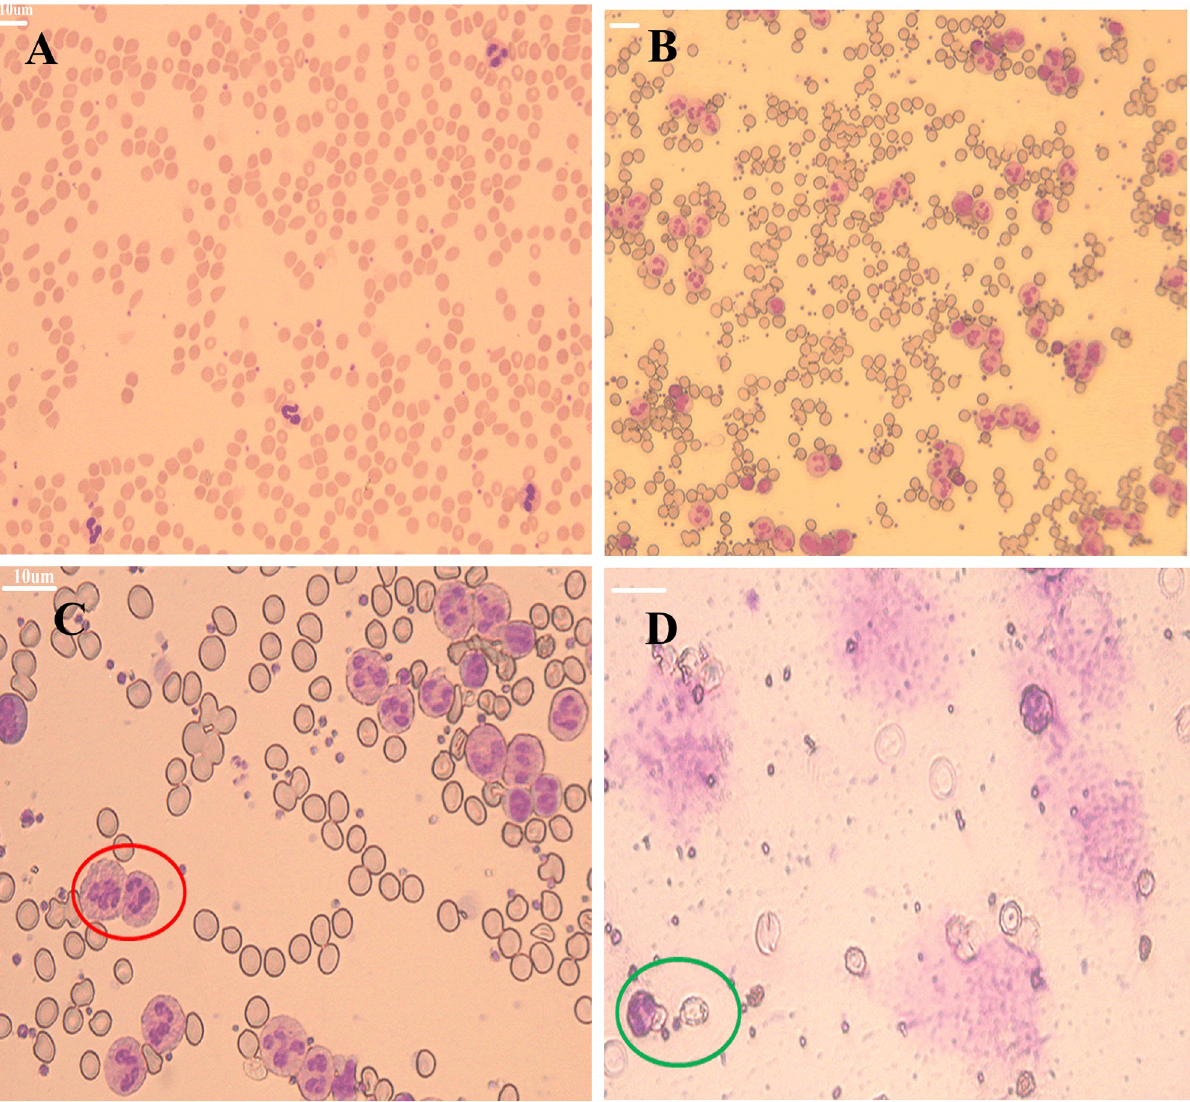
Fig 6. Morphology analysis of leukocytes respective after cell lysis and the LSA-3 pushing style method. (A) Wright-Giemsa staining of whole blood samples obtained using a 20x microscope objective. (B) The LSA-3 pushing style method of cell displacement. Leukocytes concentration has been significantly enhanced (20x objective). (C) Nucleated cells with clear cytoplasm after Wright-Giemsa staining are considered viable leukocytes (magnification, x40; representative leukocytes identified by red ellipse). (D) After cell lysis buffer treatment of whole blood cells, the leukocytes clear cytoplasm (indicating viability and homeostasis) was coated with rich erythrocyte debris (magnification, x40, identified by green